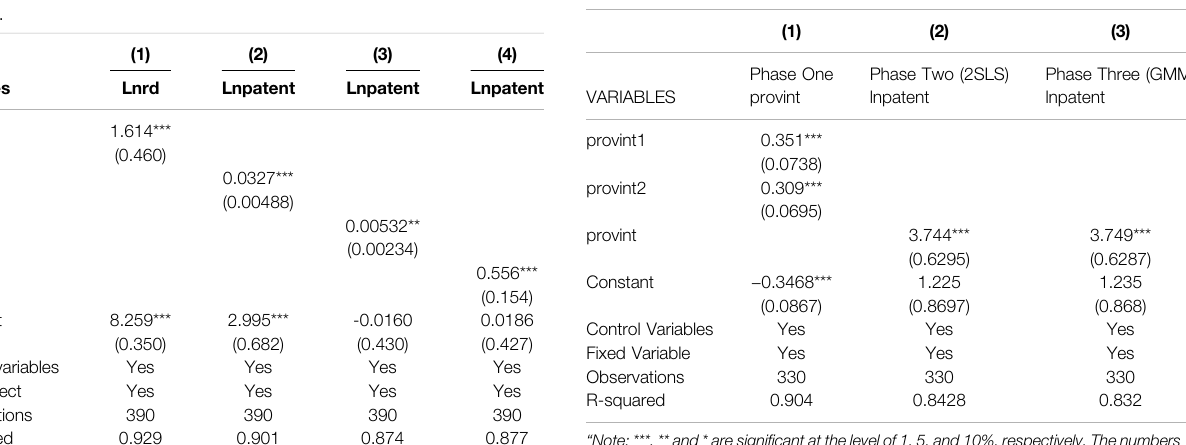
TABLE 11 | Endogeneity testing: Instrumental